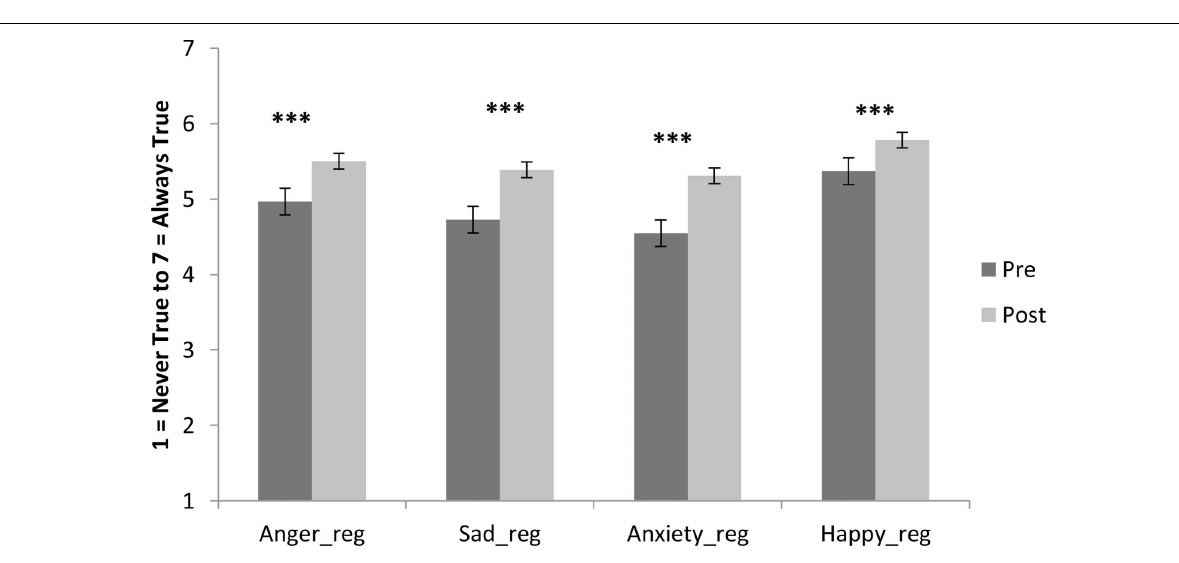
FIGURE 4 | Sample means for 216 mainstream adolescents on confidence in regulating primary emotions at pre- and post-program. (Bars are standard errors; significance ∗∗∗ p <